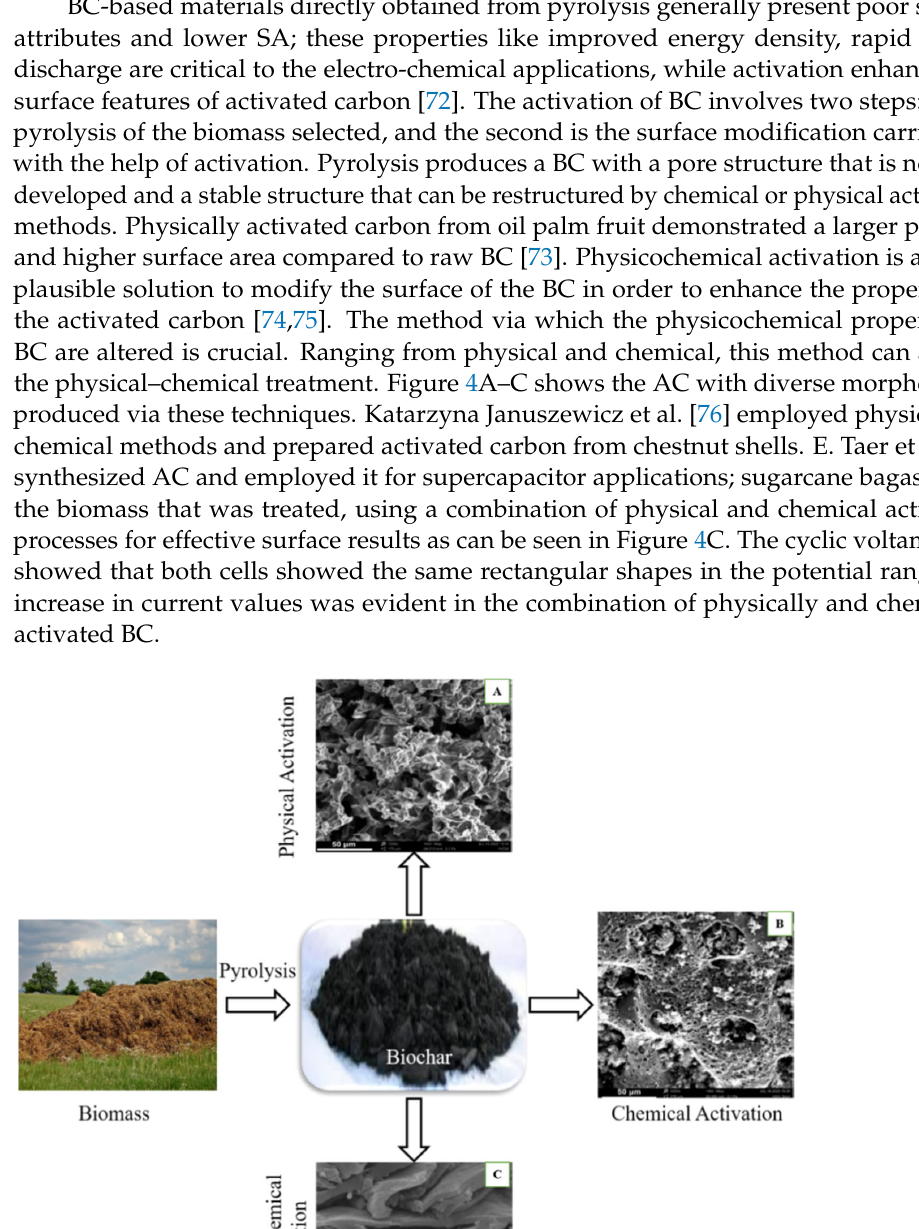
of both physical and chemical activation. ( A ) Physical activation; ( B ) chemical activation, adopted